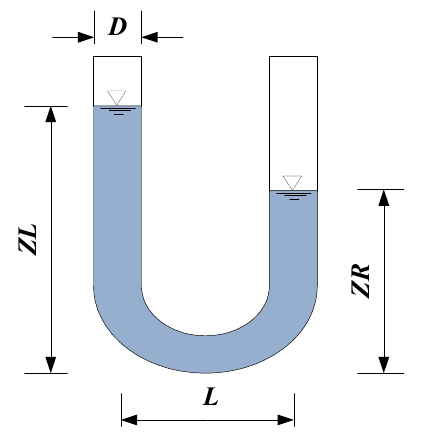
Figure 16. Schematic diagram of a